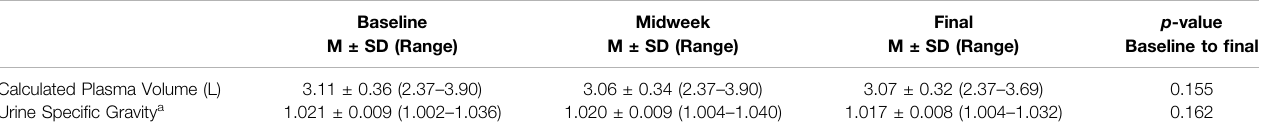
TABLE 2 | Hydration status. Calculated plasma volumes during each study time point were within the range of euhydration (2.98 – 3.19 L) (Yiengst and Shock, 1962). Baseline urine speci fi c gravity suggested mild dehydration (de fi ned as > 1.020) whereas midweek and study endpoints were within the range of euhydration to hypohydration ( ≥ 1.013 to ≤ 1.020) (Brescon et al., 2018).